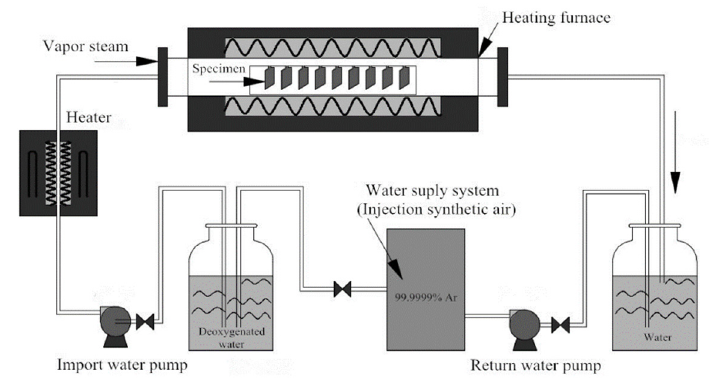
Figure 1. Schematic diagram of the water heating and loop facilities that were used for the steam oxidation experiments.